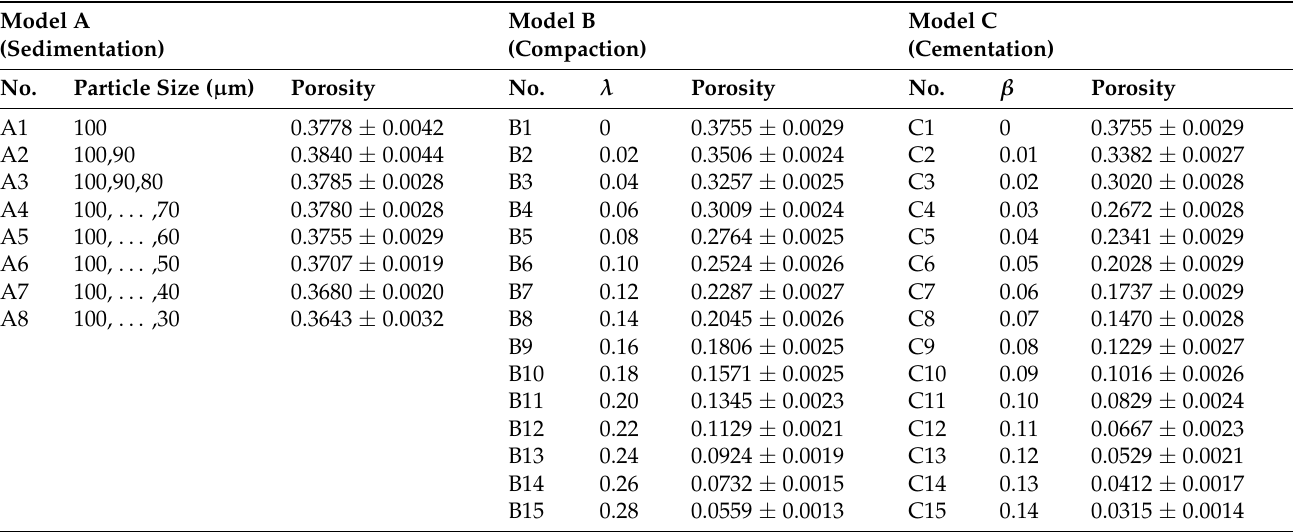
Table 2. The modeling input parameters and porosity results of sedimentation, compaction, and cementation